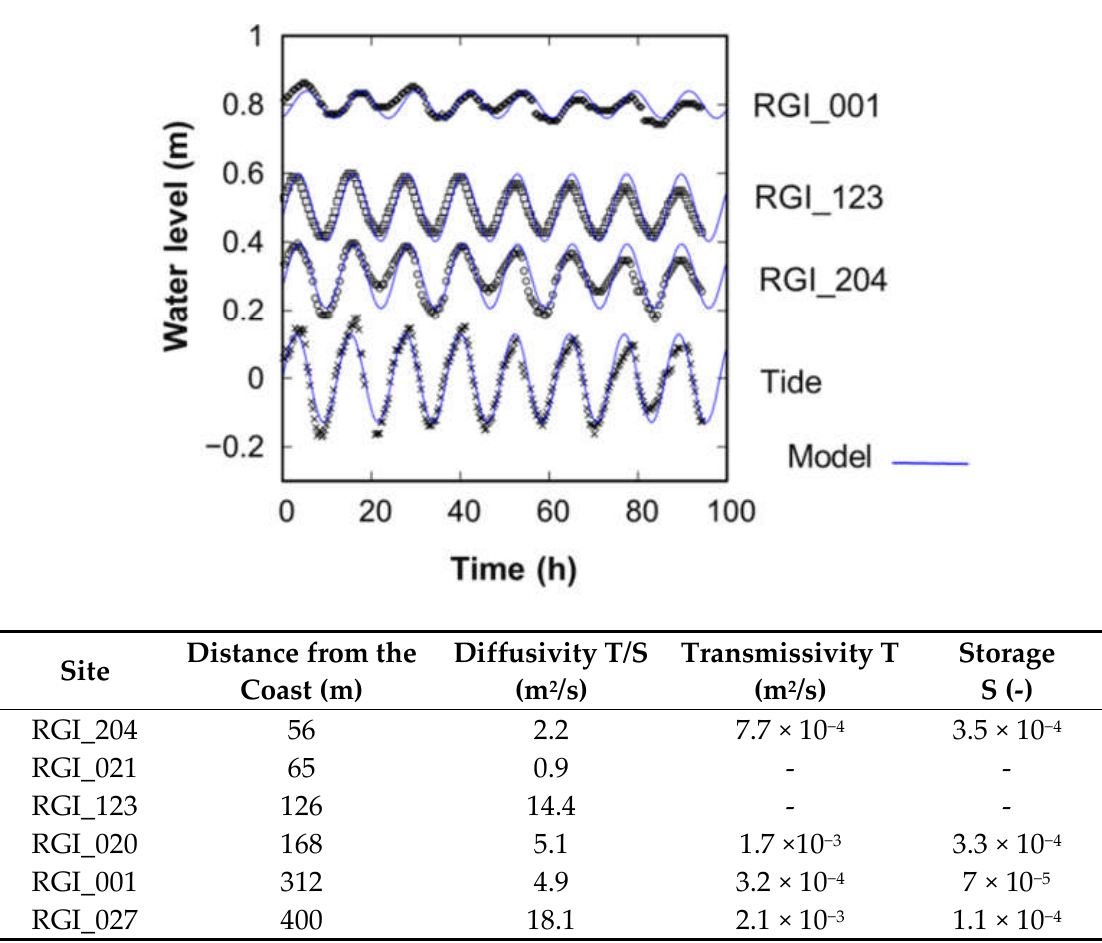
Figure 7. (Upper) Unimodal tidal model fitted over the interval 25–29 September 2018 with a period of 12.31 h (wells are classified according to distance from the coast and the average level is arbitrary) (Lower) Table with diffusivities obtained by unimodal analysis, transmissivities obtained by pumping tests and deduced storages.